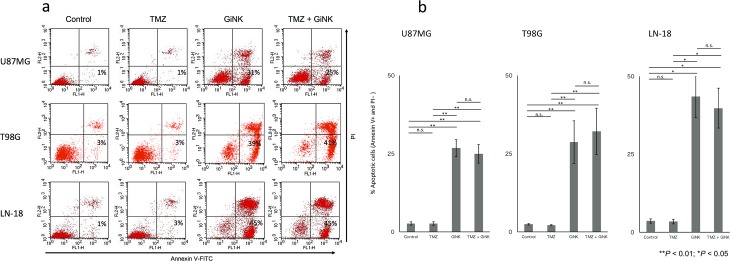
Apoptosis-inducing effects of GiNK on GBM cell lines in vitro.U87MG and T98G were exposed to GiNK at a GiNK:GBM cell ratio of 1:1, and LN-18 was exposed to GiNK at a GiNK:GBM cell ratio of 1:2 in the presence/absence of 50 μM TMZ for 24 h. Nonadherent and detached adherent cells were stained with Annexin V–FITC and PI, and the stained cells were analyzed using flow cytometry. Annexin V-positive and PI-negative apoptotic cells are shown as a percentage of apoptotic cells from the total number of counted cells. (a) Representative dot plots of Annexin V–PI two-color flow cytometric analysis of U87MG, T98G, and LN-18 cells, respectively. (b) The graphs show the percentages of Annexin V-positive and PI-negative apoptotic cells of U87MG (n = 7), T98G (n = 11), and LN-18 (n = 6) cells. Data indicated as mean ± SE. P values were determined using the Kruskal–Wallis test followed by Steel–Dwass’s test. Statistically significant differences: **P < 0.01, *P < 0.05.